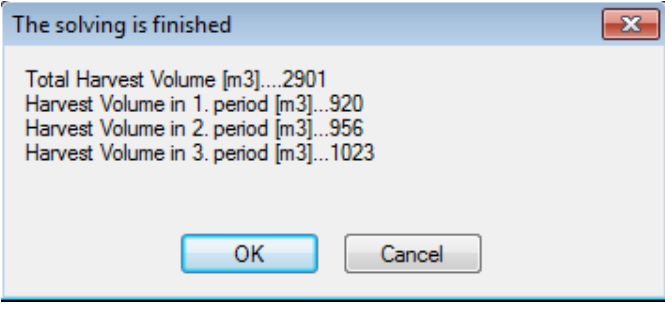
Figure 4. The summary